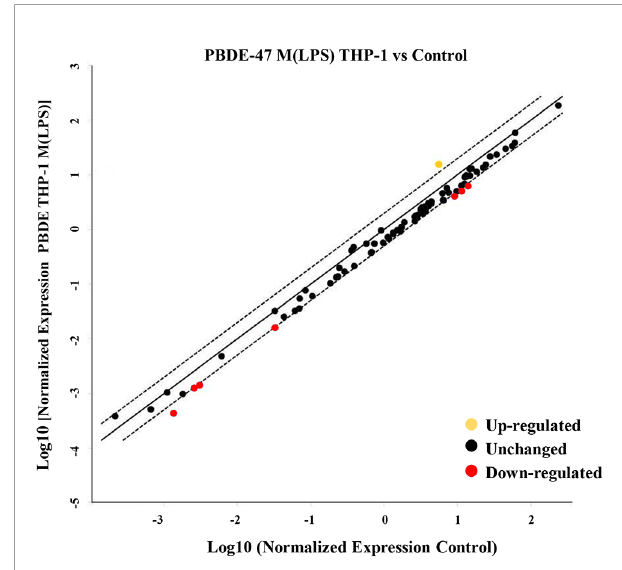
FIGURE 1 | MiRNA Array. Evaluation of differential intracellular miRNA expression in cDNA derived from M(LPS) THP-1 macrophages treated with PBDE-47. The CT data obtained from control and treated plates were analyzed by Gene Globe Data Analysis Center (https://geneglobe.qiagen. com/us/analyze/) The yellow dot indicates the up-regulated miRNA (fold change >2), red and black indicate down-regulated (fold change <0.5) and unchanged miRNAs,